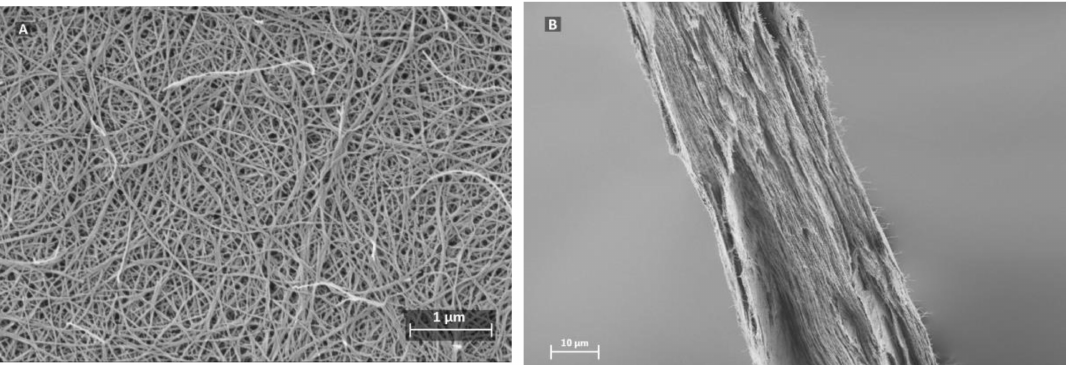
Figure 1. Scanning electron microscope (SEM) images of ( A ) top and ( B ) cross-section of the nanocellulose filter, featuring non-woven, and layered